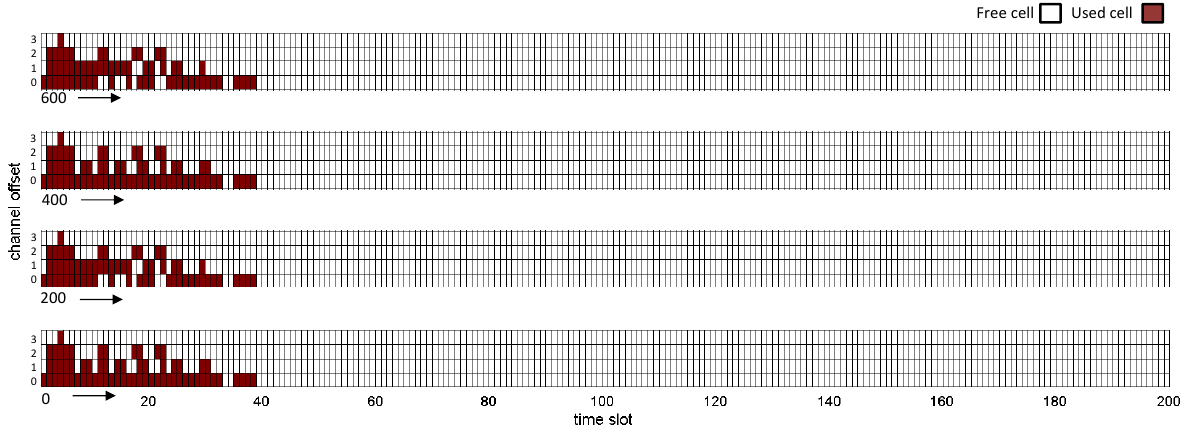
Figure 16. The global matrix of the current slot/channel usage for the simulated WirelessHART network.